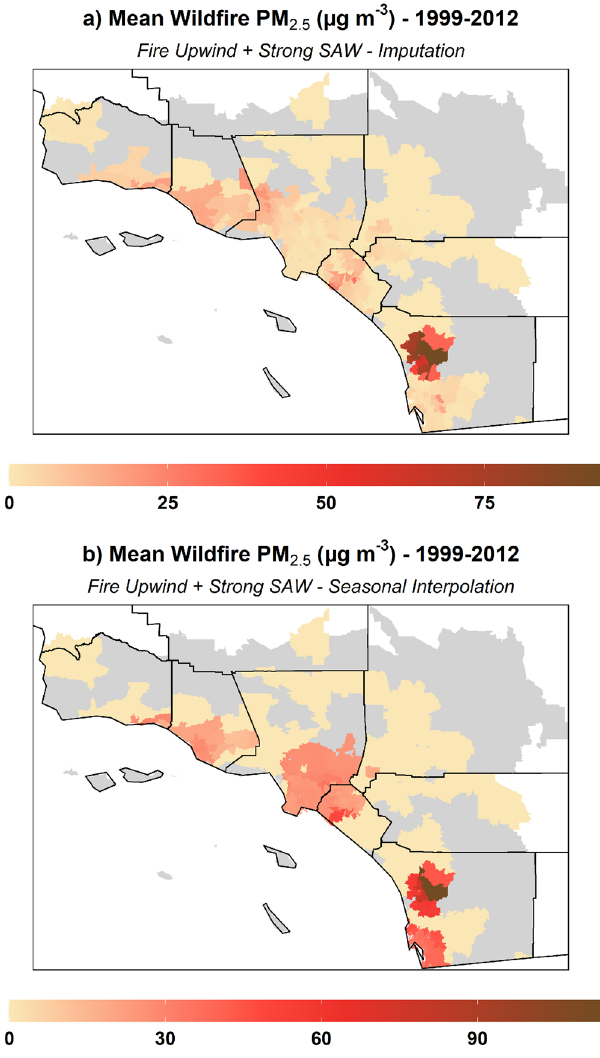
Fig. 3 Wild fi re-speci fi c concentrations of PM 2.5 . Mean wild fi re-speci fi c PM 2.5 estimated by a imputation and b seasonal interpolation methods and using the fi re upwind and strong SAW exposure de fi